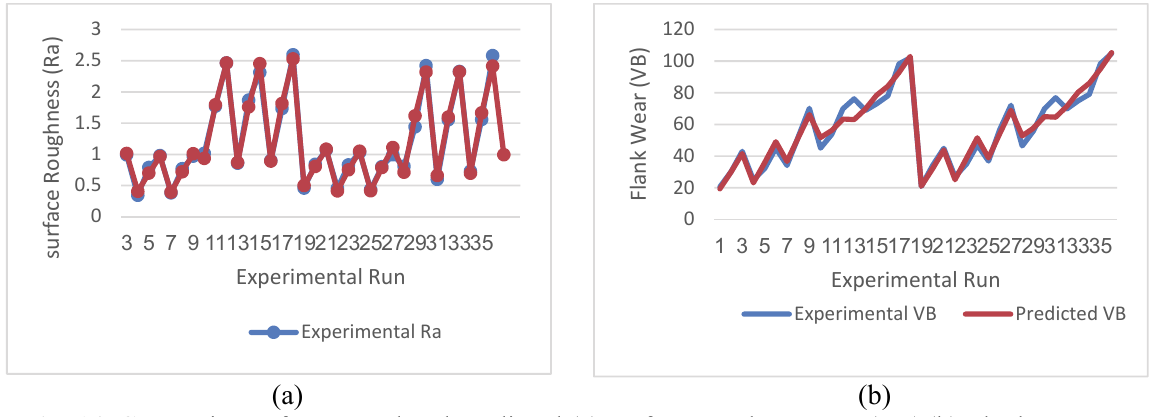
Fig. 14. Comparison of measured and predicted (a) surface roughness, Ra (µm) (b) Flank wear, VB